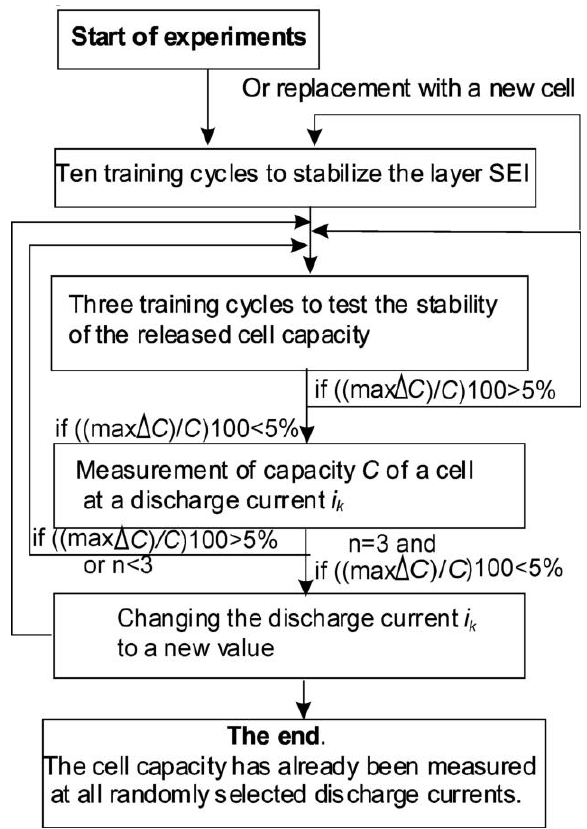
Figure 1. The scheme of the measurement algorithm. max ∆ C is the maximum difference for the three measured capacities at a certain discharge current i k . n is the number of charge/discharge cycles at a certain discharge current i k .